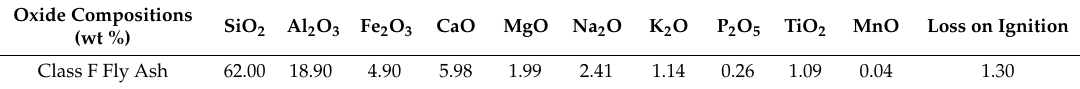
Table 1. Oxide composition of Class F fly